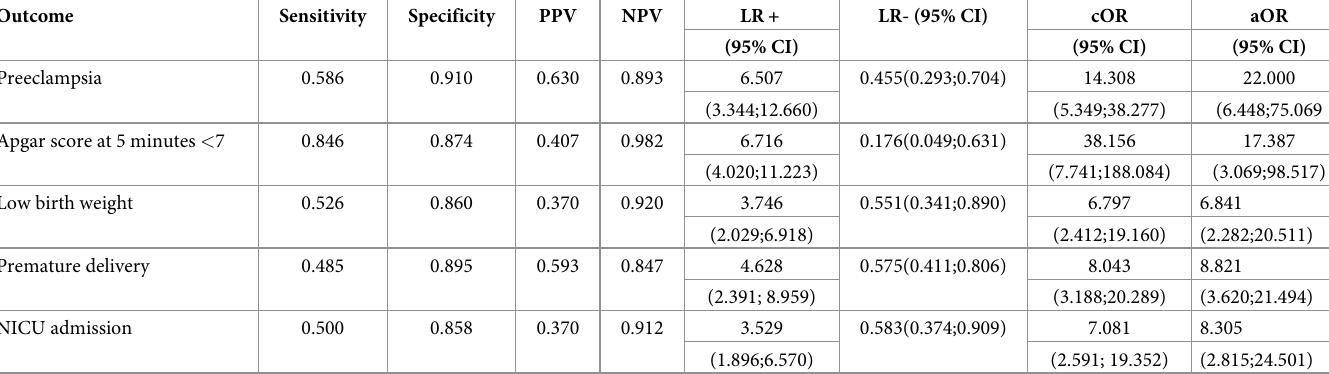
Table 4. The validity of sFLT-1/PlGF ratio test in predicting preeclampsia and low Apgar score at 5 minutes. Outcome